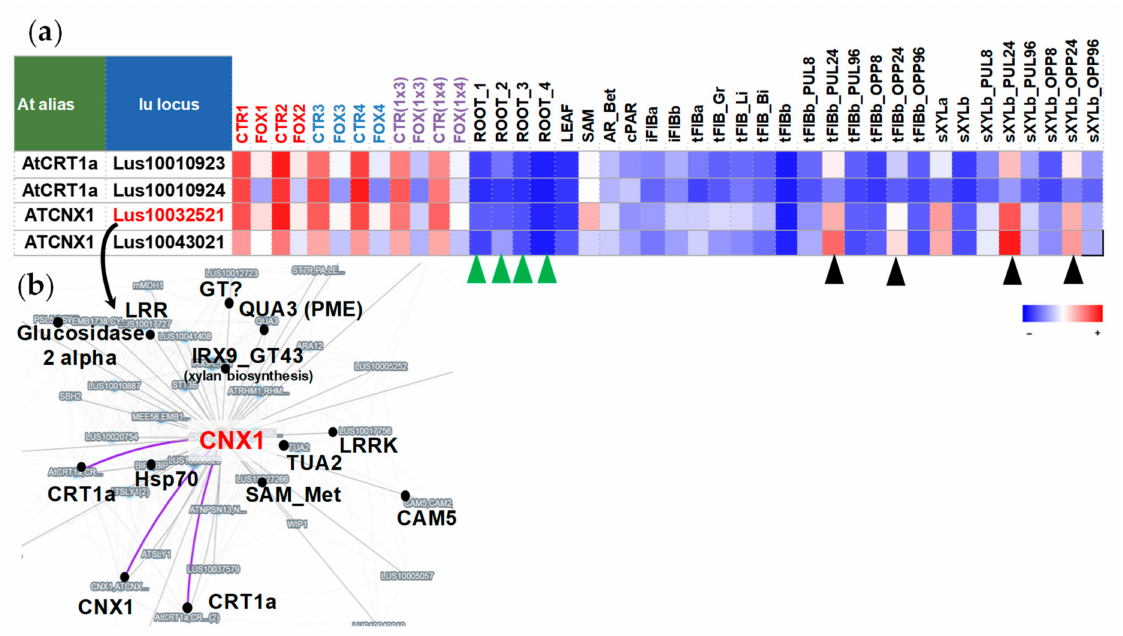
Figure 4. ( a ) The expression of genes for the Calreticulin (PF00262) family (calreticulins and calnexins) in different flax tissues. Black arrows mark stem samples (phloem fibers and xylem part) after gravistimulation [6]. Green arrows mark control root samples from an experiment with aluminum treatment [20]. The detailed sample descriptions and references are presented in FIBexDB and the supplementary file of the related paper [12]. The color gradient of the red-blue heatmap reflects TGR values from minimum (blue) to maximum (red) in the row. ( b ) The coexpression network of calreticulin LusCNX1 ( Lus10032521